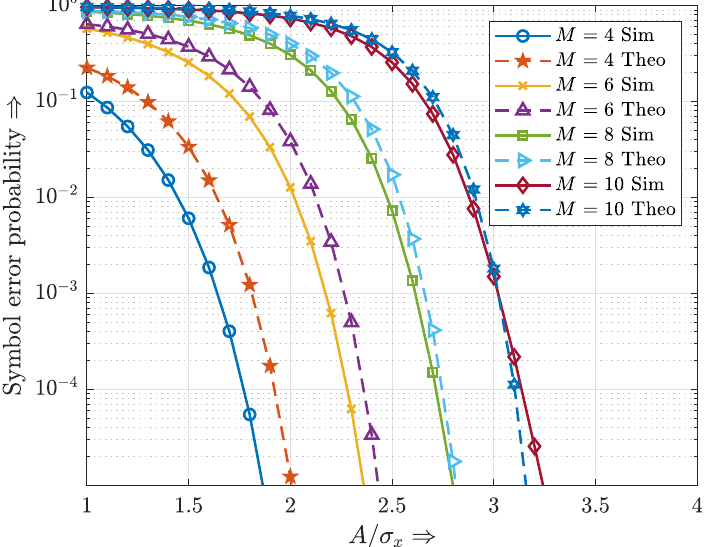
Figure 10. Simulated and analytical calculated symbol error probability for a 2 M -QAM OFDM- transmission that suffers from clipping at level A